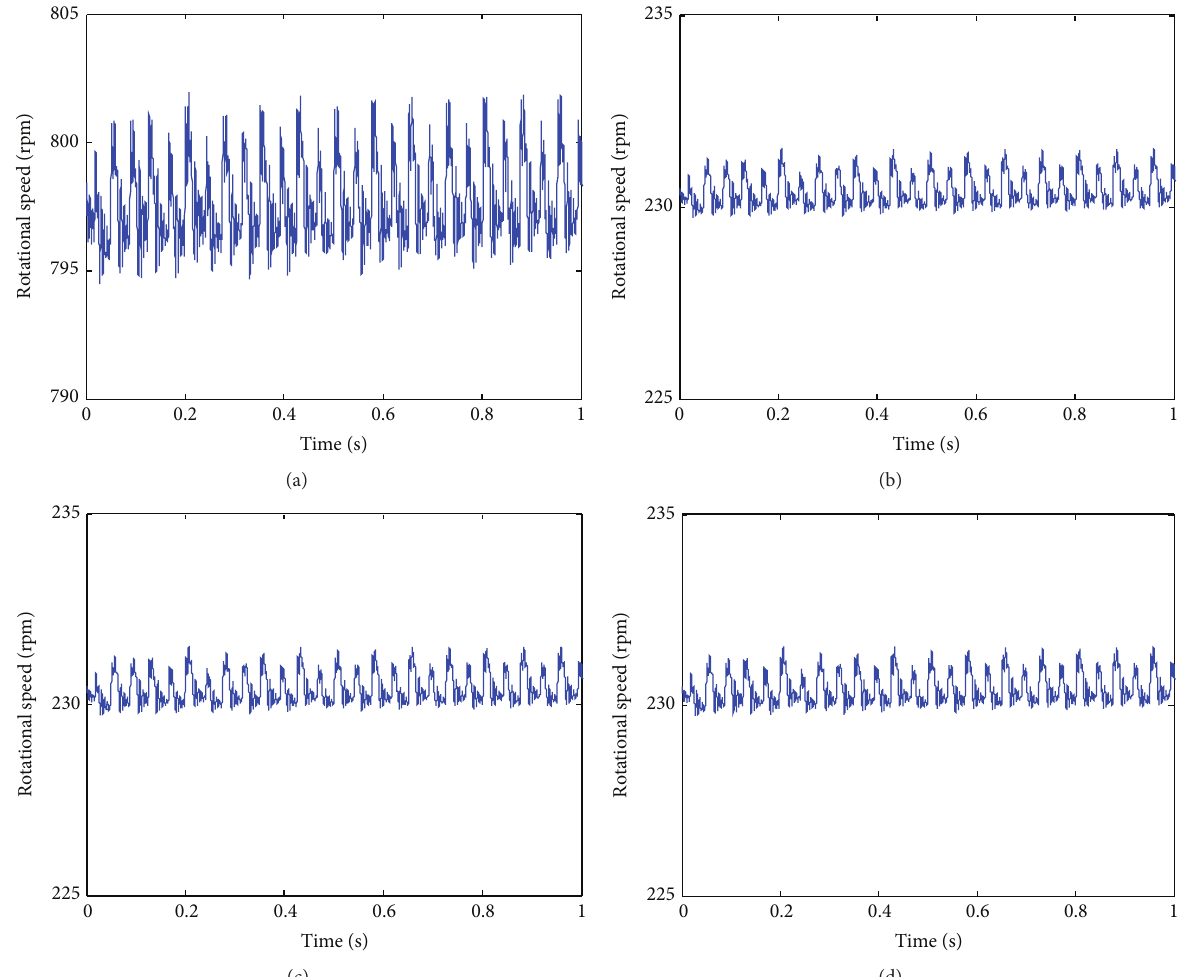
Figure 29: Pinion gear speed of all unloaded gear pairs: (a) the 2nd gear pair, (b) the 3rd gear pair, (c) the 4th gear pair, and (d) the 5th gear